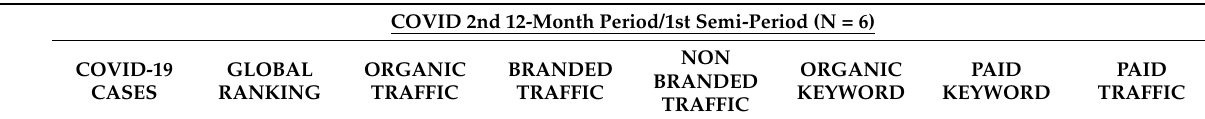
Table 7. Statistically significant correlation matrix after PCC-r analysis (COVID 2nd 12-month period/1st semi-period).